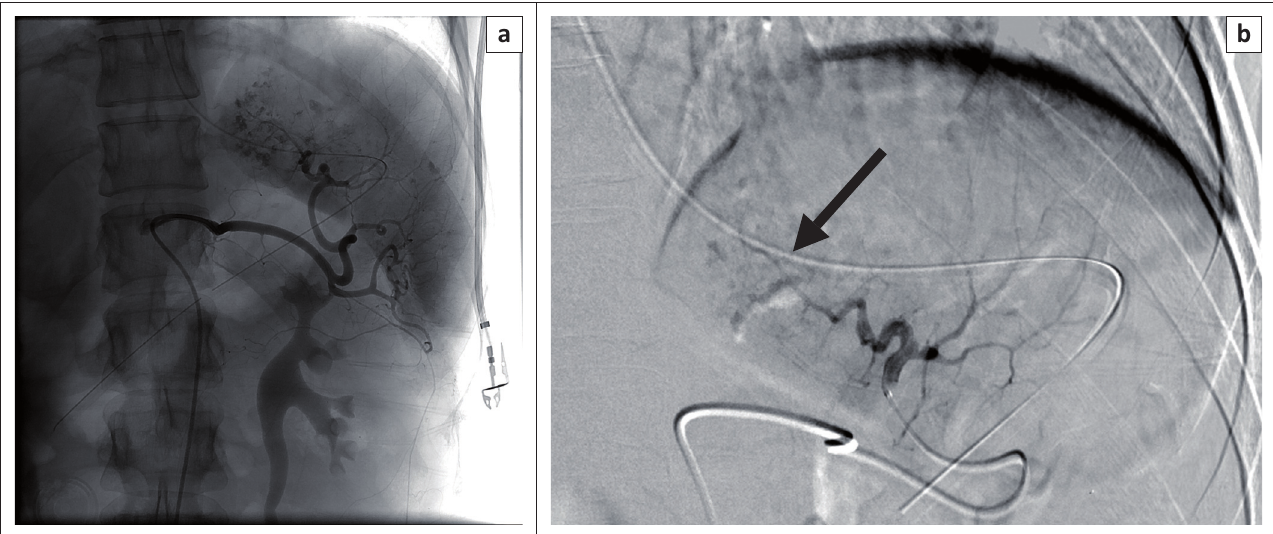
FIGURE 2: Fluoroscopic images demonstrating: (a) angiography of the main splenic artery with a splenic contusion and pseudoaneurysm formation and (b) coil embolisation of both the proximal main and distal (black arrow) splenic